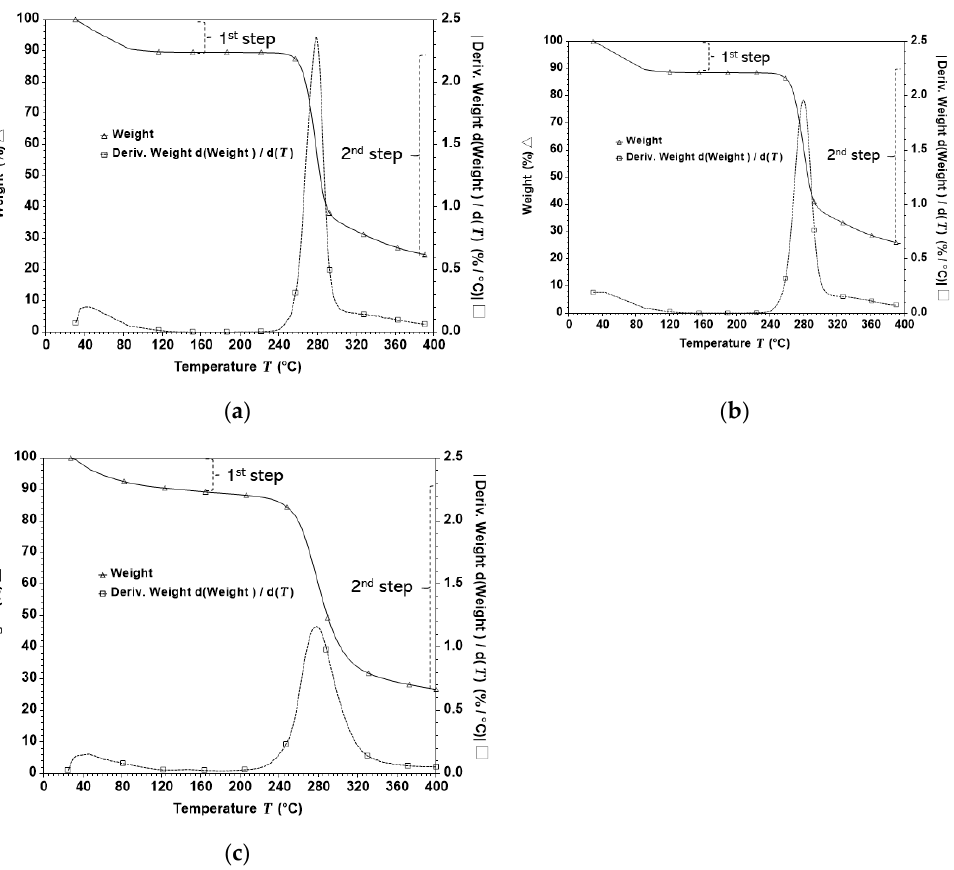
Figure 4. Typical TGA thermograms and their derivative weight of isolated starch ( a ), starch from processing medium ( b ), and potato powder ( c ) from untreated and PEF-treated potatoes. The thermograms are similar for each fraction among PEF treatments analysed in triplicate.